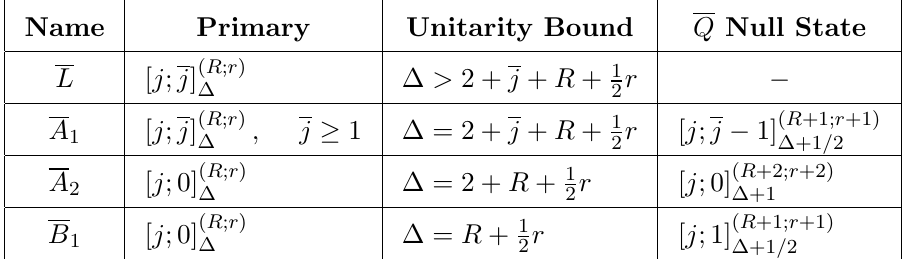
Table 14 . Q shortening conditions in four-dimensional N = 2 SCFTs. Full N = 2 multiplets are two-sided: they are obtained by imposing both left Q and right Q unitarity bounds and shortening conditions. This can lead to restrictions on some quantum numbers. The consistent two-sided multiplets are summarized in table